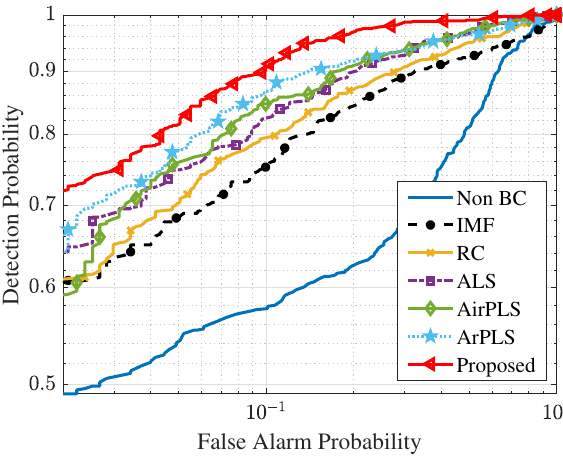
Figure 7. ROC curves of the ASD for the PH